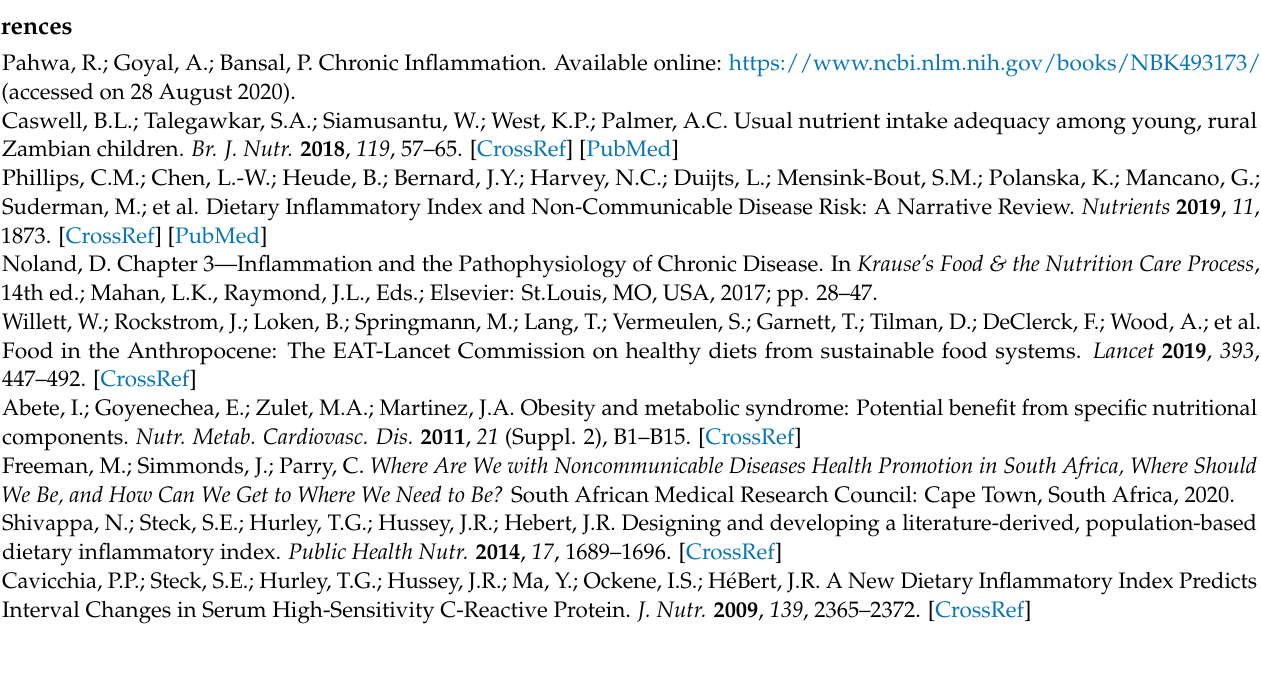
SD = Standard Deviation; PDIS = Provincial Dietary Intake Study; SA = South African; EAR = Estimated Average Requirements (mass/day); g = grams; mg = milligrams; mcg = micrograms. Bonferroni multiple comparison: significant differences between mean ± SD values of different age groups depicted with different letters, p <